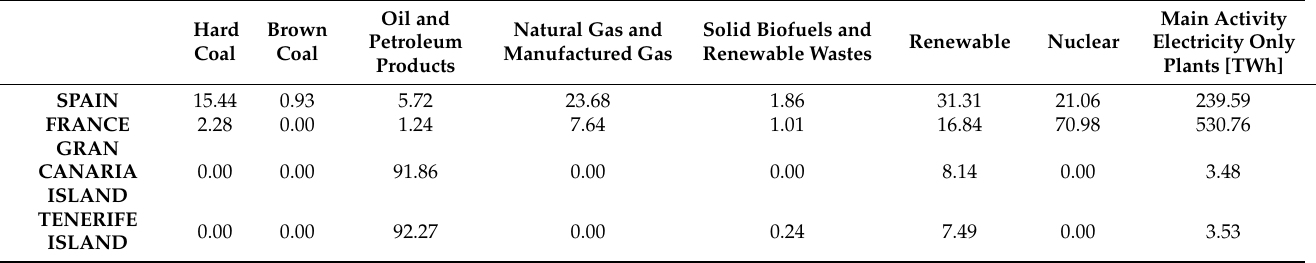
Table 4. Gross electricity generation by fuel in 2017